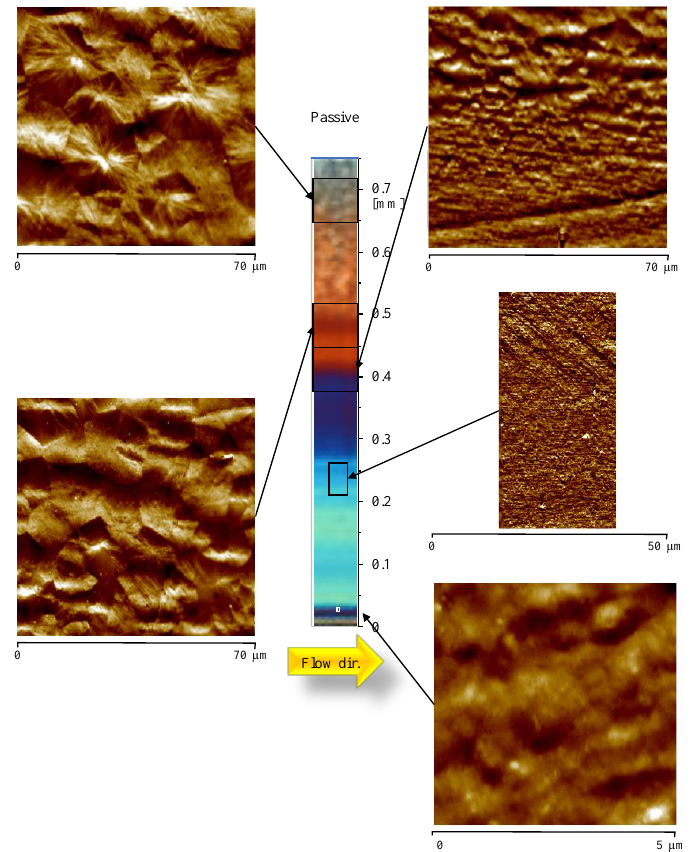
Figure 2. Optical micrograph and AFM height maps, at different distances from the sample surface, of the sample Passive, at 15 mm downstream the gate.